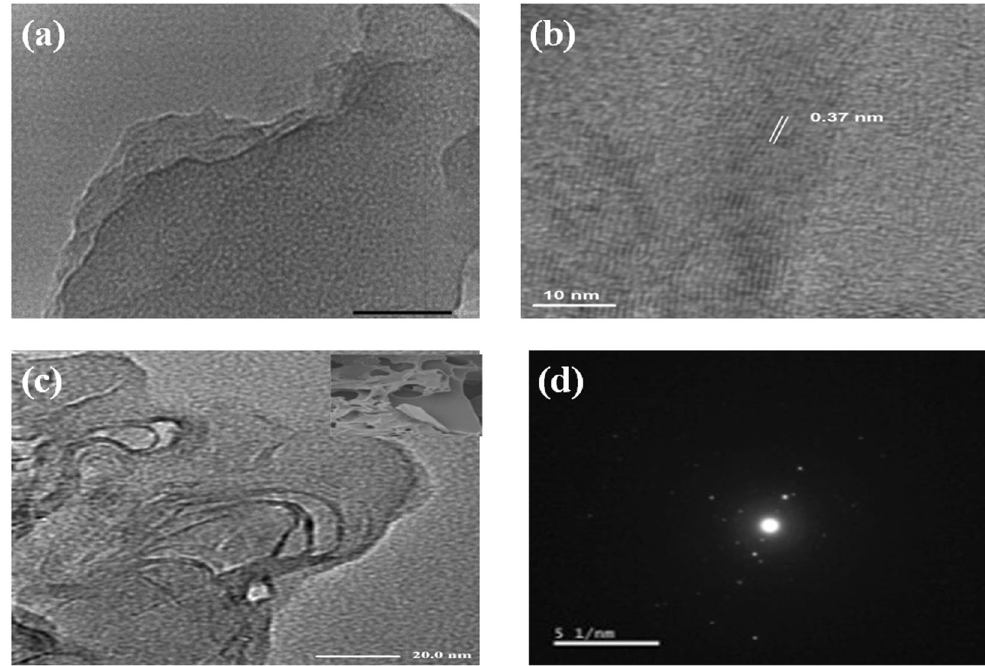
Figure 2. ( a ) TEM image and ( b ) HR-TEM image of sample 6 G, ( c ) corresponding TEM image with inset SEM image and ( d ) selected area diffraction pattern (SAED) of sample 4NG.